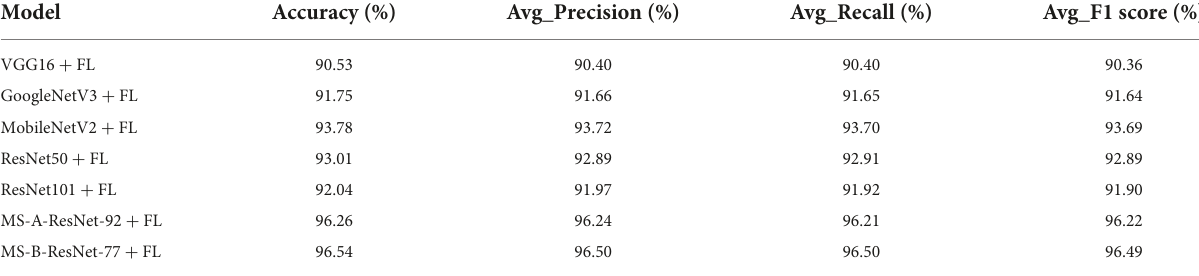
TABLE 9 Performance comparison of different models using focal loss